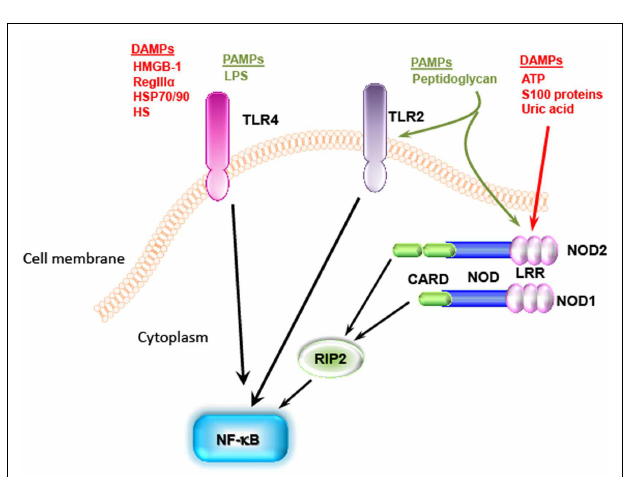
FIGURE 2 |Toll-like receptors and IL-1 receptor family signaling pathways . ST2L (IL-33r) and IL-1r signal through the MyD88, IRAK4, andTRAF6 pathway. ST2L and IL-1r share this pathway with most TLRs. Binding of ST2L, IL-1r, andTLRs activates NF- κ b, resulting in the release of inflammatory cytokines. MostTLRs signal through MyD88